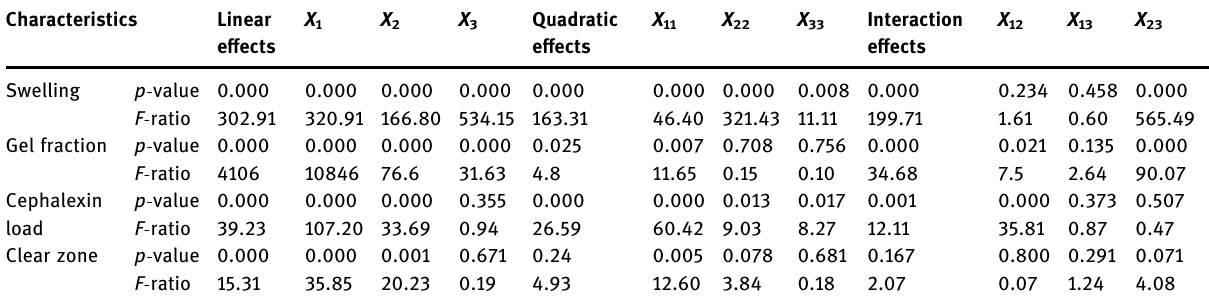
Table 2: ANOVA results and p - values and F - ratio of linear, quadratic, and binary interaction terms in suggested models for prepared sodium alginate/AAc composite hydrogels conjugated to silver nanoparticles Characteristics